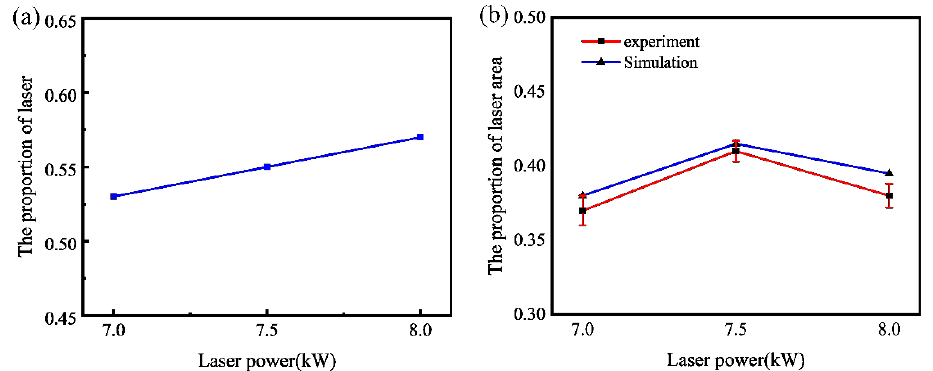
Figure 8. ( a ) Laser power share, ( b ) laser zone area share.